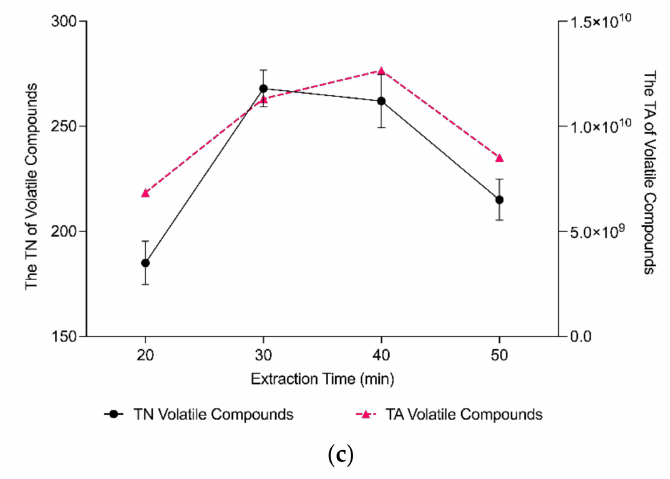
Figure 1. The effect of different extraction parameters of HS-SPME on the total number (TN) and total area (TA) of volatile compounds in sourdough: heating temperature ( a ); equilibrium time ( b ); extraction time ( c ).